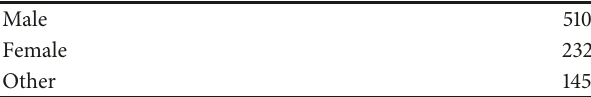
Table 1: Number of gender attributes for the data sets.